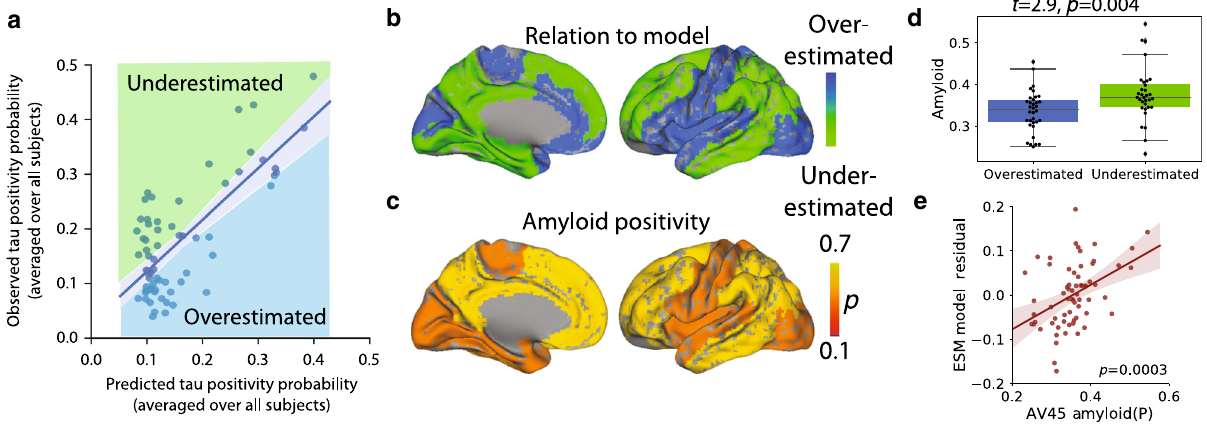
Fig. 6 Amyloid explains regional model underestimation. a Regions were classi fi ed as overestimated or underestimated based on the sign of the residual in a comparison of predicted vs. observed values. b A cortical surface render showing the spatial distribution of over- and underestimated regions. c A surface render showing the spatial distribution of regional amyloid-positive probabilities averaged over all subjects. d Underestimated regions tended to have signi fi cantly greater amyloid burden, suggesting these regions had more tau than would be predicted given their connectivity to the model epicenter. For boxplots, the center line = median, box = inner quartiles, whiskers = extent of data-distribution except * = outliers. e Correlation between regional model residuals and regional amyloid. Each point is a brain region, and the y -axis summarizes the degree to which a region was underestimated (positive) or overestimated (negative) by the model.